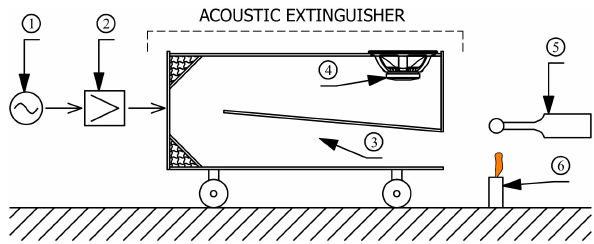
Figure 2: Experimental set-up diagram 1) signal generator, 2) power amplifier, 3) waveguide, 4) loudspeaker, 5) sound level meter,